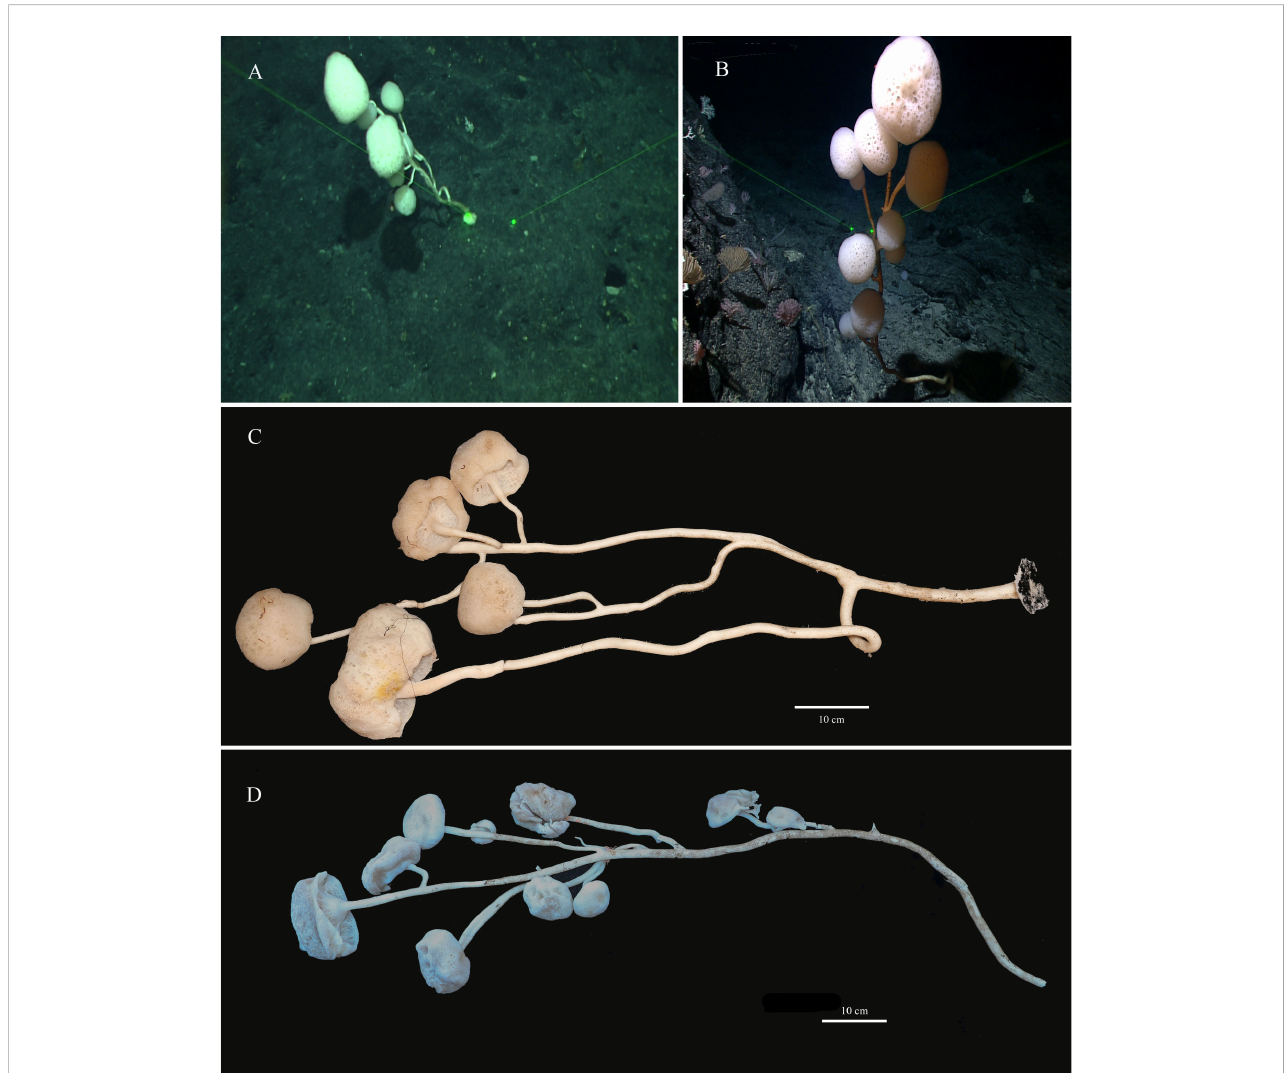
FIGURE 2 Caulophacus ( Caulodiscus ) iocasicus sp. nov. (A) , photograph showing the holotype specimen in its natural habitat. (B) , photograph showing the paratype specimen in its natural habitat. (C) , external morphology of the holotype after removal from seawater. (D) , external morphology of the paratype after removal from